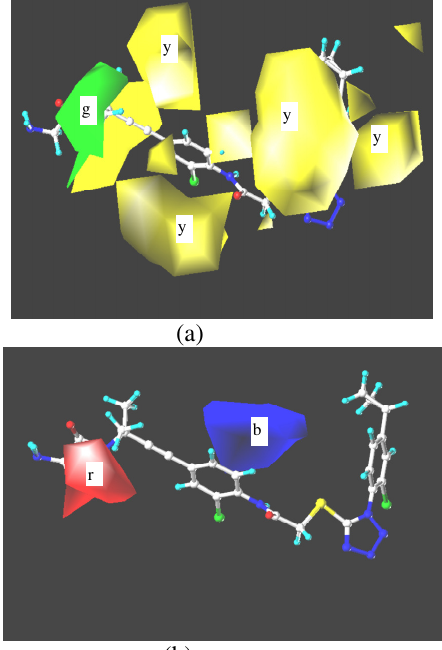
Figure 4. CoMFA Stdv*Coeff. contour plots (a) the steric field distribution and (b) the electrostatic field distribution for high active compound 27. Green (g) contour maps for sterically favored areas and sterically disfavored areas in yellow (y). Positive potential favored areas in blue (b), negative potential favored areas in red